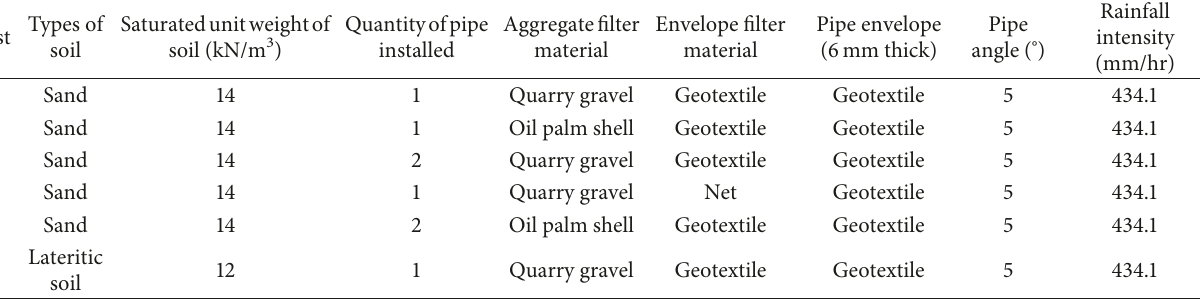
Table 4: Details of experiments performed in this